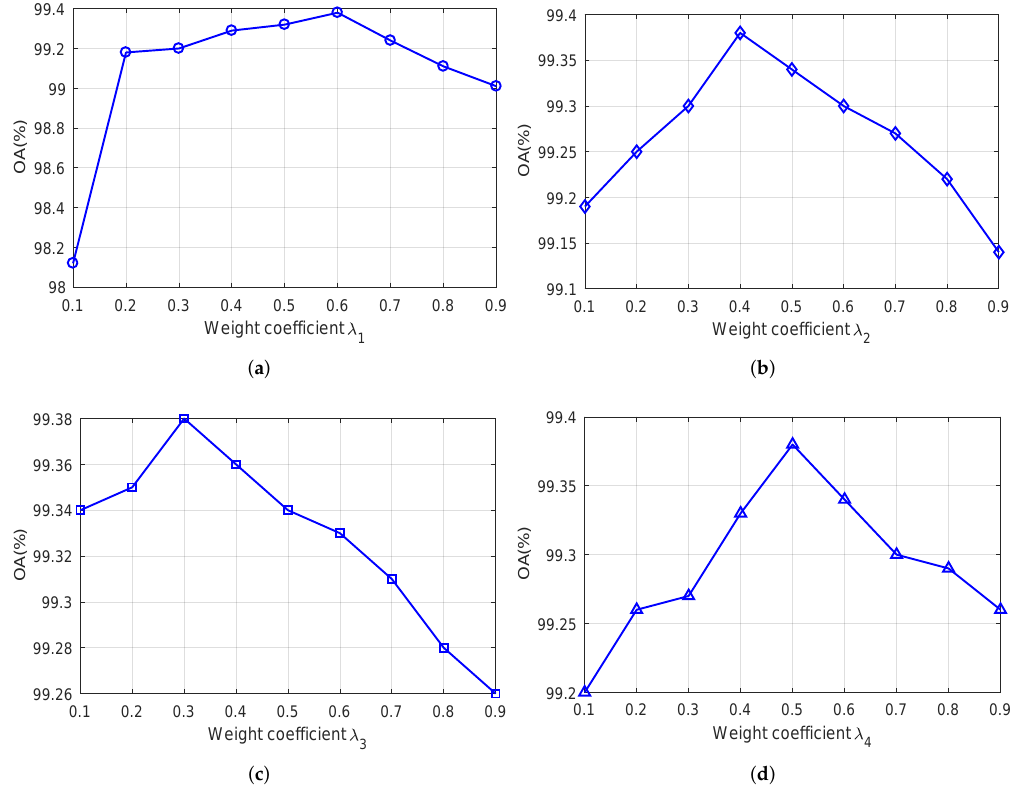
Figure 2. Classification accuracy versus different weight coefficients on the synthetic PolSAR dataset.